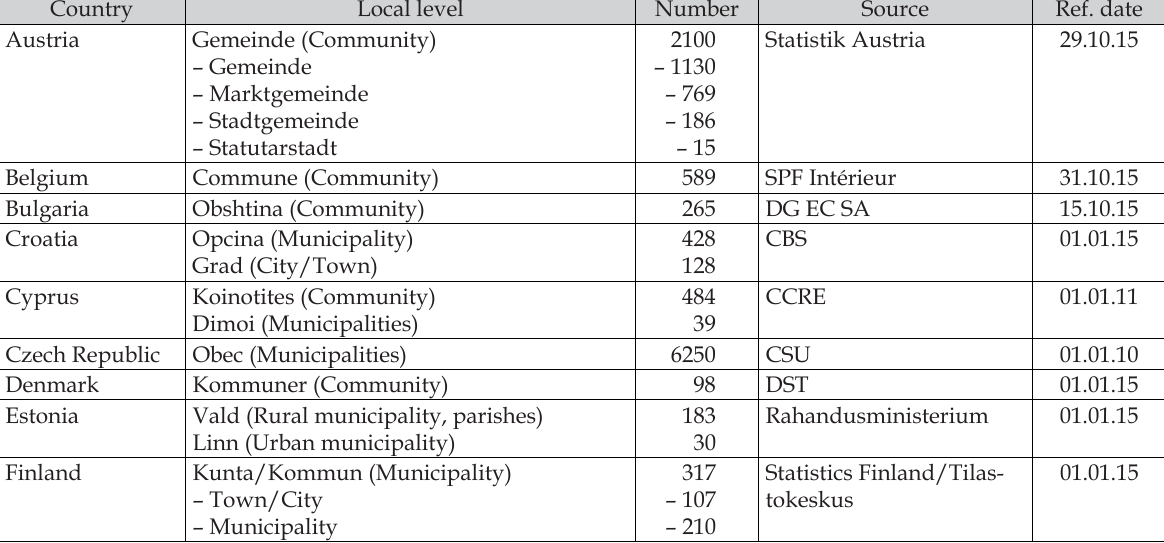
Table 1. Political-administrative local units in European countries and their national typologies, sources and reference